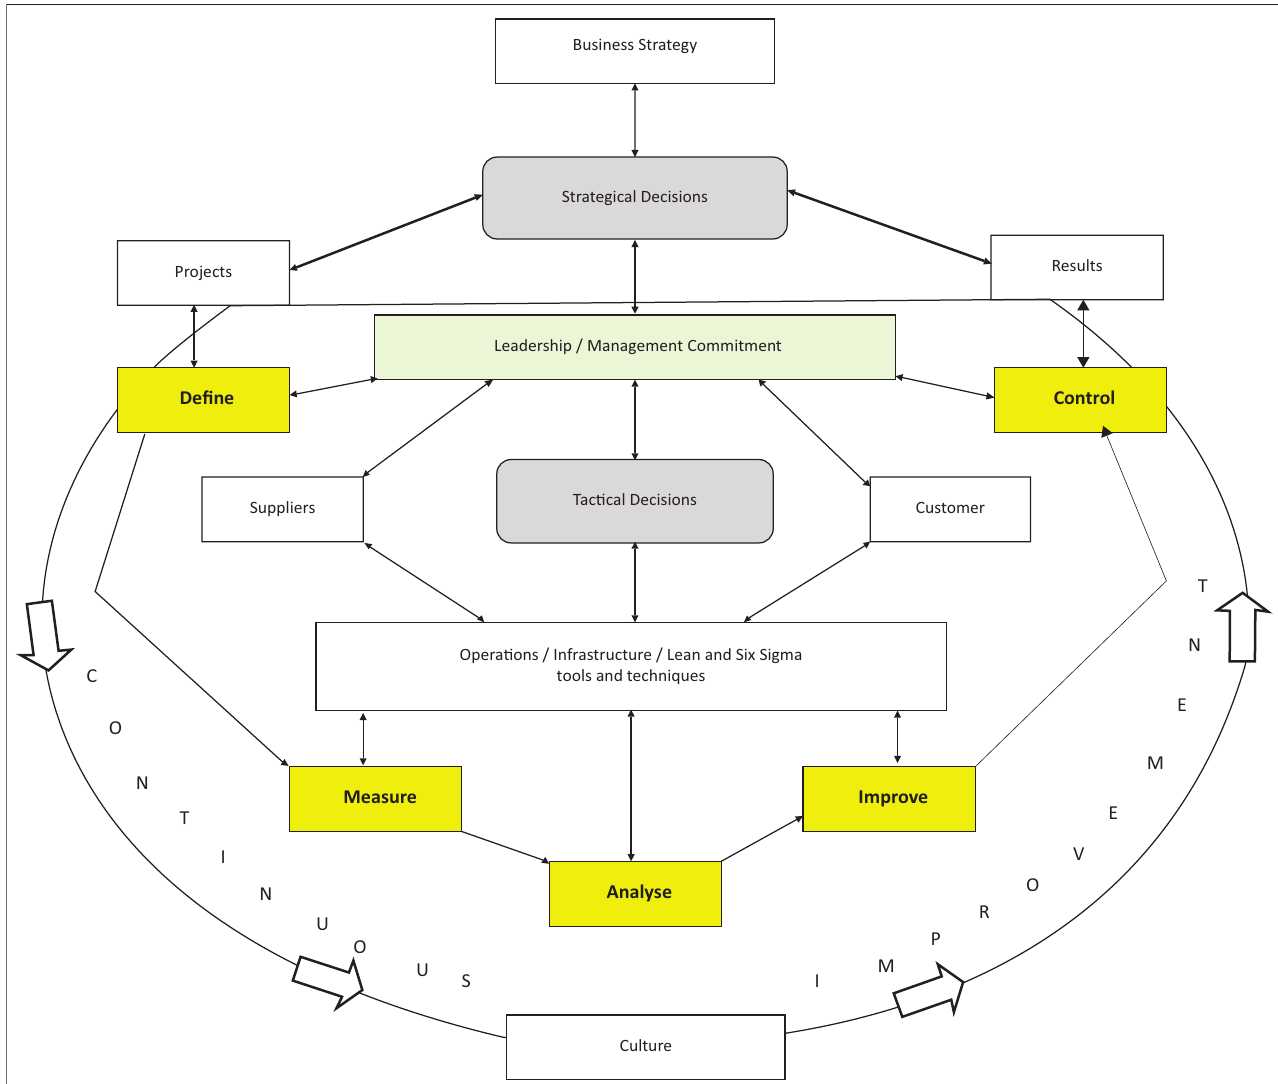
FIGURE 2: Lean Six Sigma